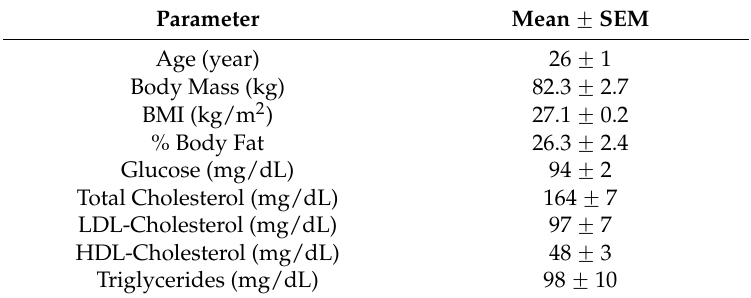
Table 2. Baseline subject characteristics mean and standard error (SEM) ( n =